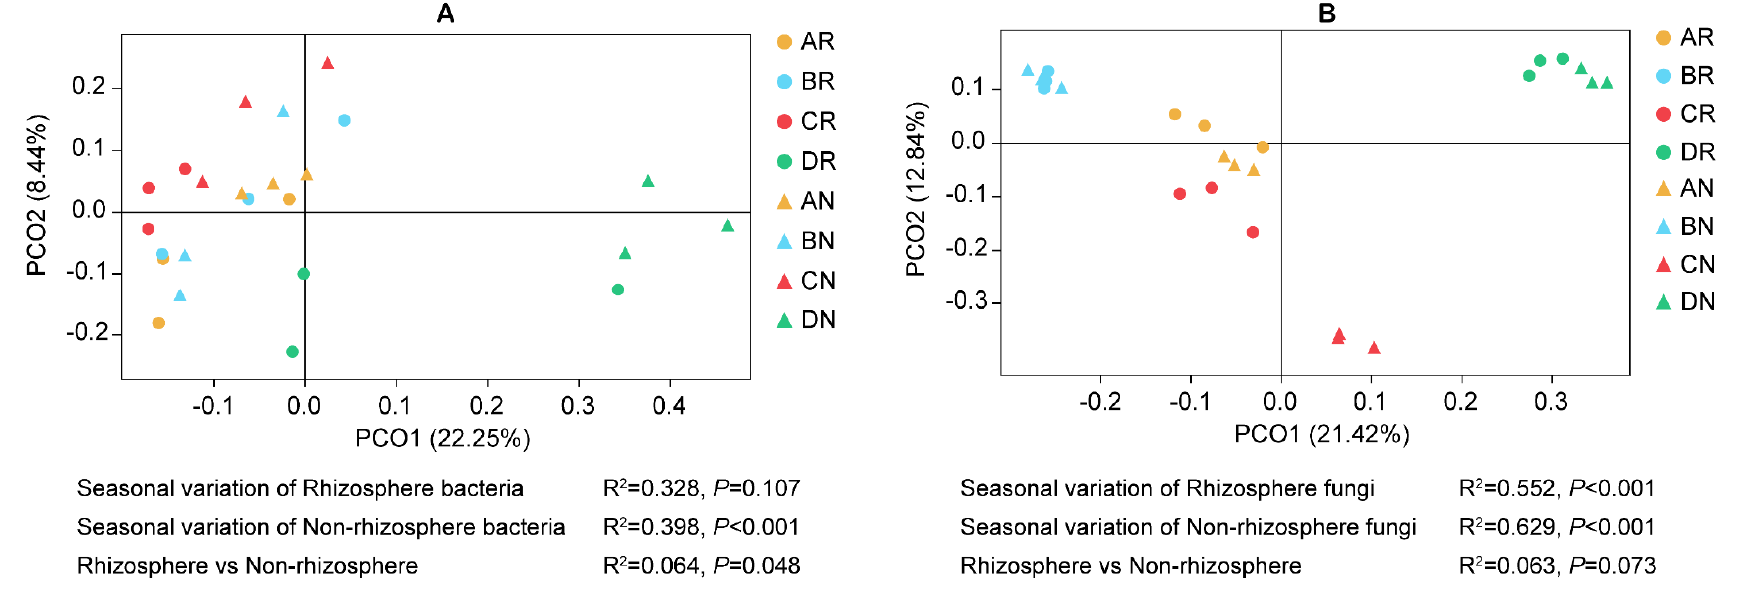
Figure 3. Principal Co-ordinary Analysis (PCoA) of bacterial ( A ) and fungal ( B ) community based on unweighted unifrac distance. AR, BR, CR, and DR indicates rhizosphere soil sample in spring, summer, autumn, and winter, respectively. AN, BN, CN, and DN indicates non-rhizosphere soil sample in spring, summer, autumn, and winter, respectively. Values of R2 and P were calculated using Permutational MANOVA (Permanova). n = 3.